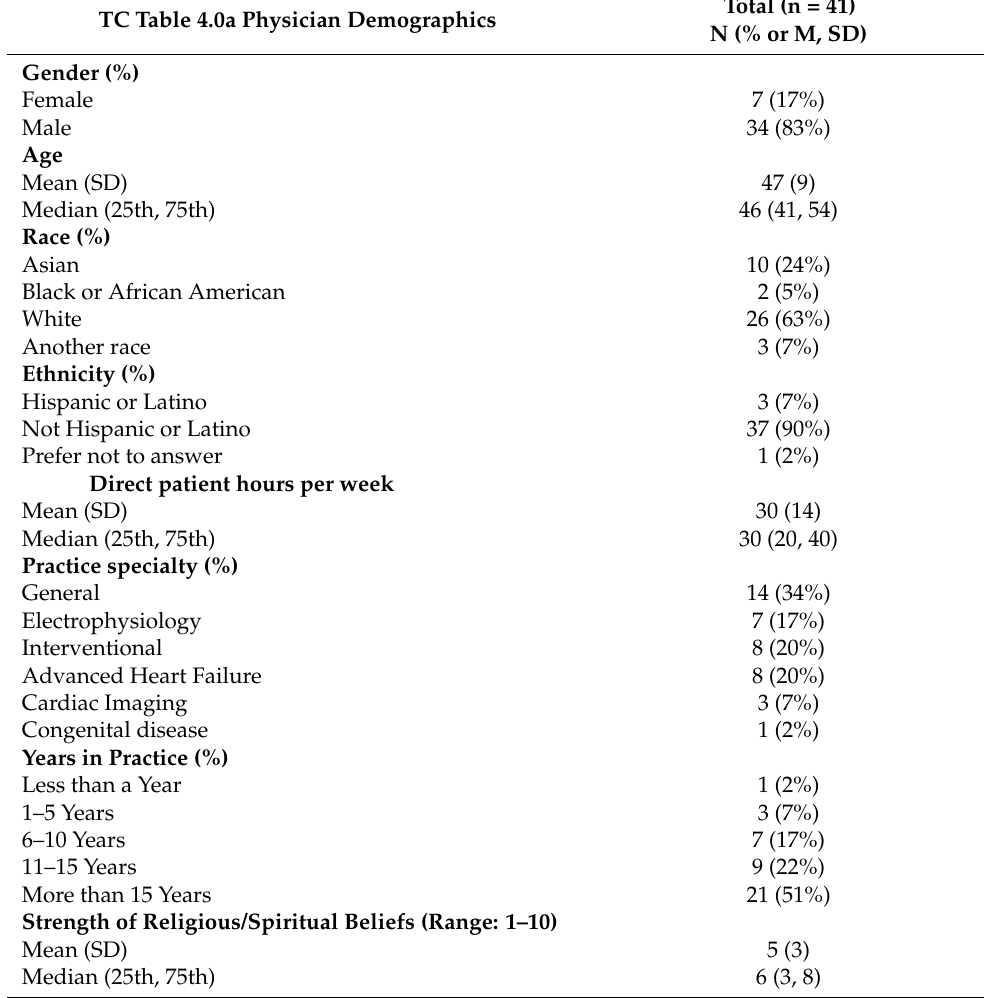
Table 1. Cardiologist demographic characteristics. TC Table 4.0a Physician